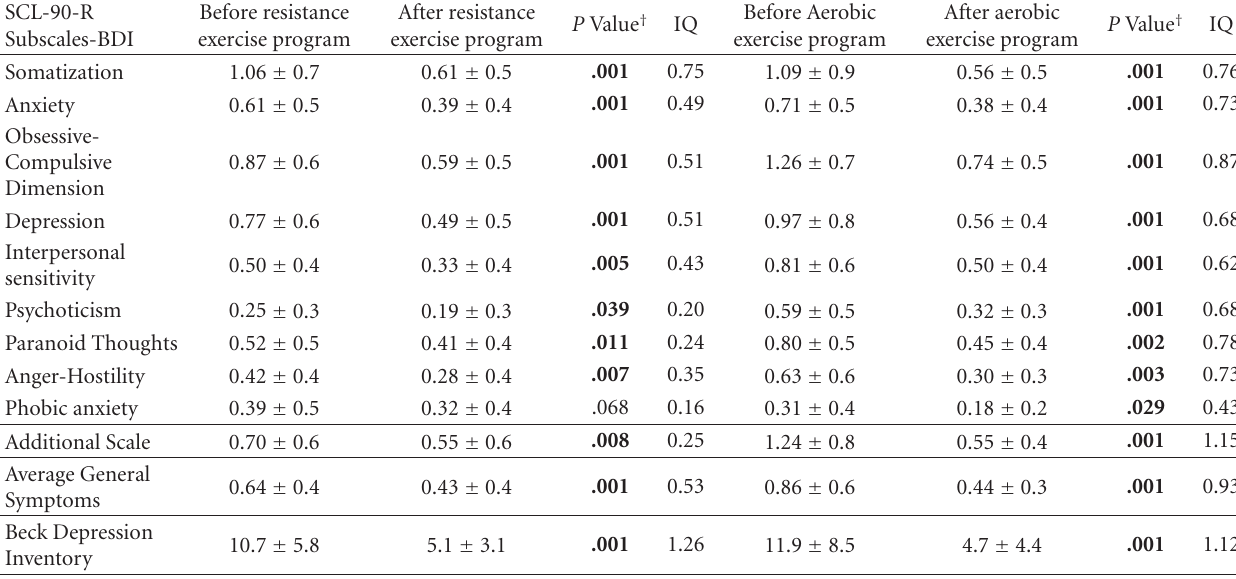
Table 4: SCL-90-R subscale and BDI points of Aerobic and Resistance exercise groups before and after the exercise program X ± SD, N = 18. SCL-90-R